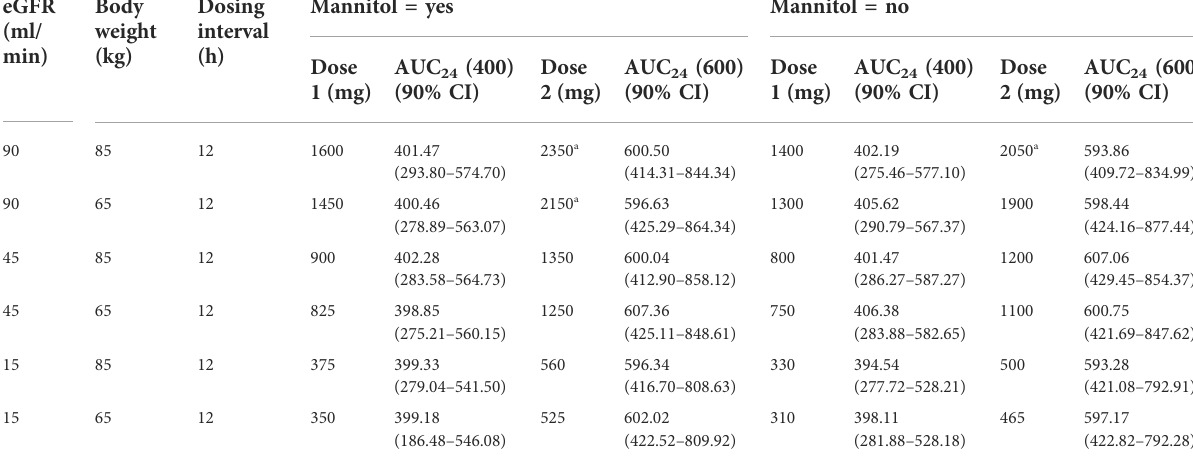
TABLE 4 The simulated dose regimen in patients with typical characteristics by the fi nal model. eGFR